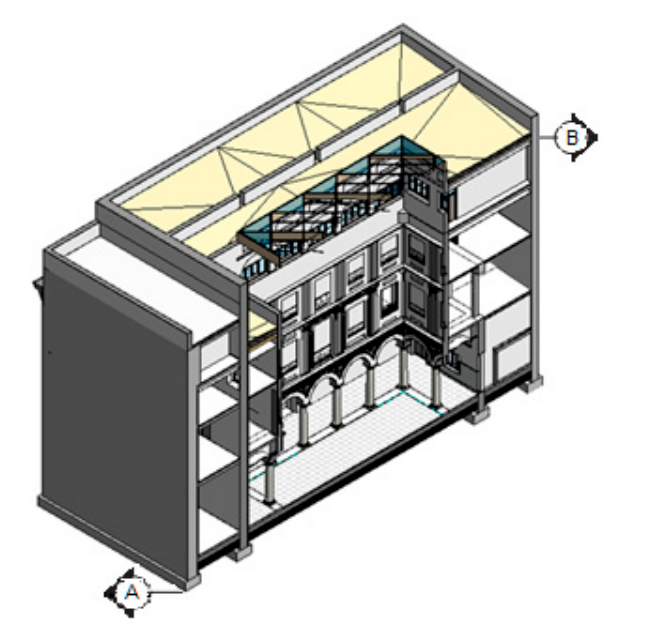
Figure 4. 3D cross section of the building.